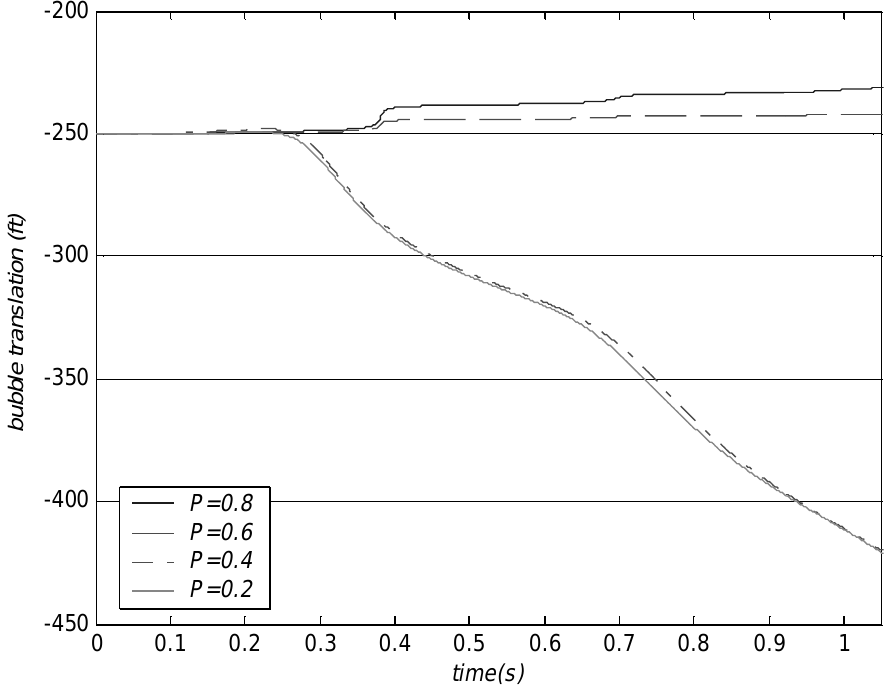
Fig. 2. Translation histories for a 1000-lb charge of TNT detonated at a depth of 250 ft, calculated with C = 1.0 and various values of P